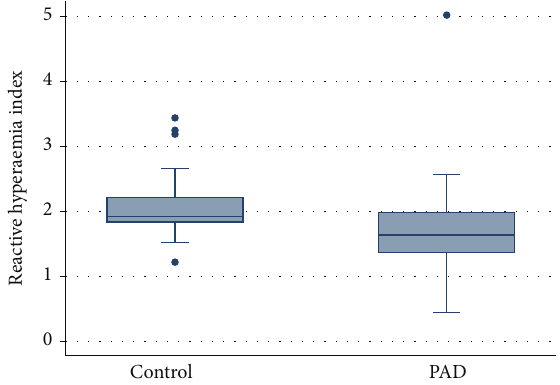
Figure 1: Plot of distribution of RHI values for age and gender matched controls and patients with PAD, 𝑝 = 0.005 .